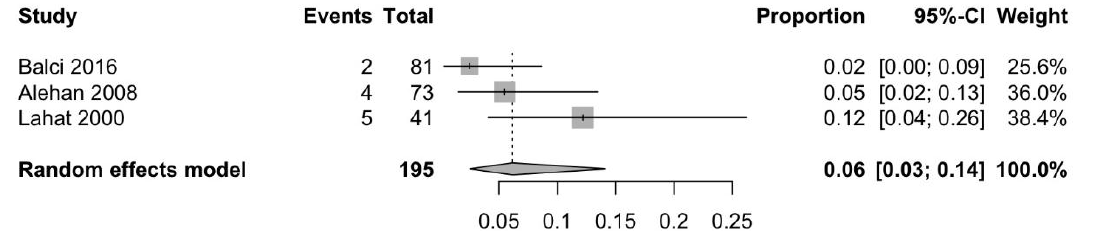
Figure 6. Pooled mean prevalence of serologically confirmed gluten sensitivity in children with idiopathic migraine.